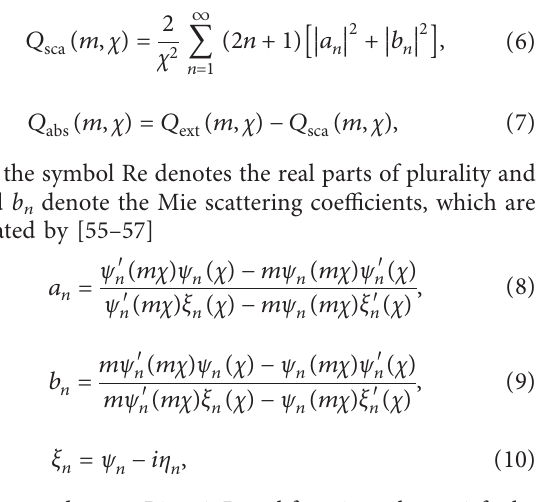
Figure 1: Schematic diagrams of ellipsometry measurements based on the “prism-liquid”